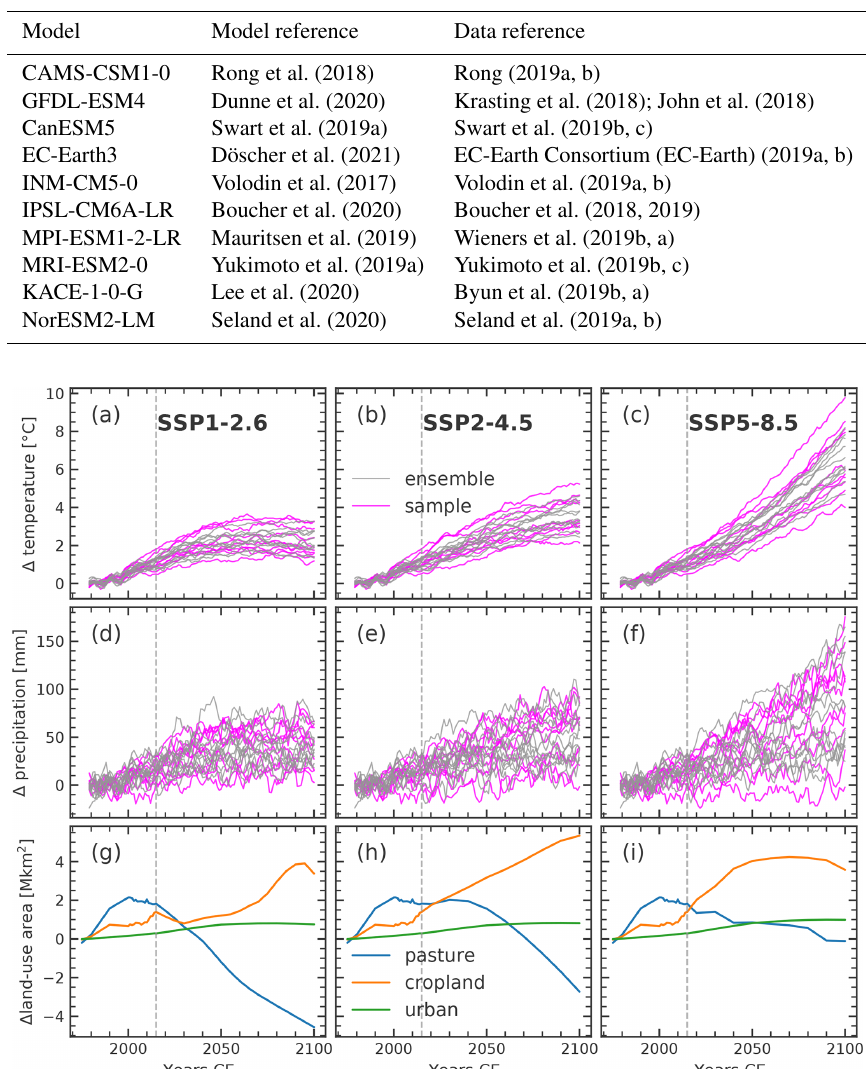
Table 1. Ensemble of CMIP6 earth system models used to force the LPX-Bern. Output data were used for monthly precipitation, surface temperature, and cloud cover from the “r1i1p1f1” variant of the respective historical simulations and future scenarios SSP1-2.6, SSP2-4.5, and SSP5-8.5